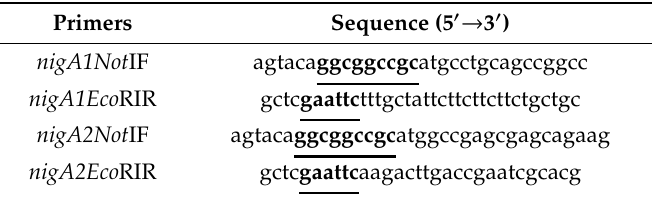
Table 1. List of primers used for this